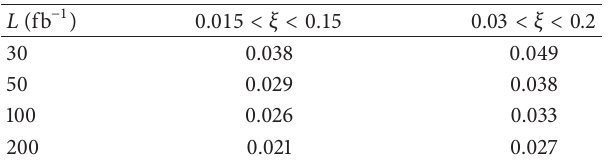
Table 1: 95% CL bounds on the anomalous coupling 𝜅 𝑡𝑞𝛾 for various forward detector acceptances and integrated LHC luminosities. The center of mass energy of the proton-proton system is taken to be √𝑠 = 14 TeV.